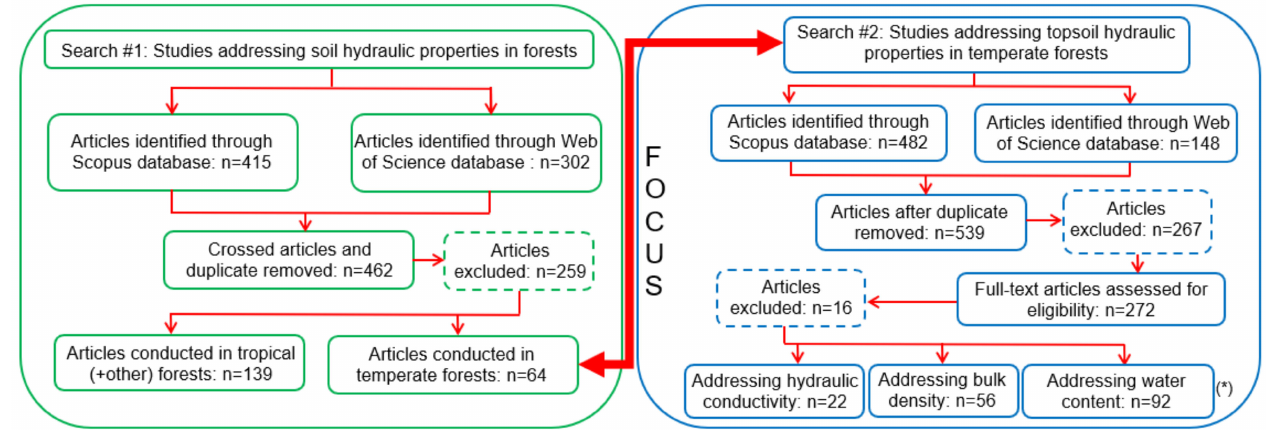
Figure 1. The flowchart on the left displays the steps performed in a first broad search, which shows the current state of the literature in relation to the variation in soil hydraulic properties in different climatic zones. The flow chart on the right illustrates the steps followed to filter the studies related to soil hydraulic properties in temperate forests (the focus) and how the final database based on current literature was compiled. The number of papers found (n) and the studies that were discarded at each step along the literature review are included. (*) Some articles are repeated between the